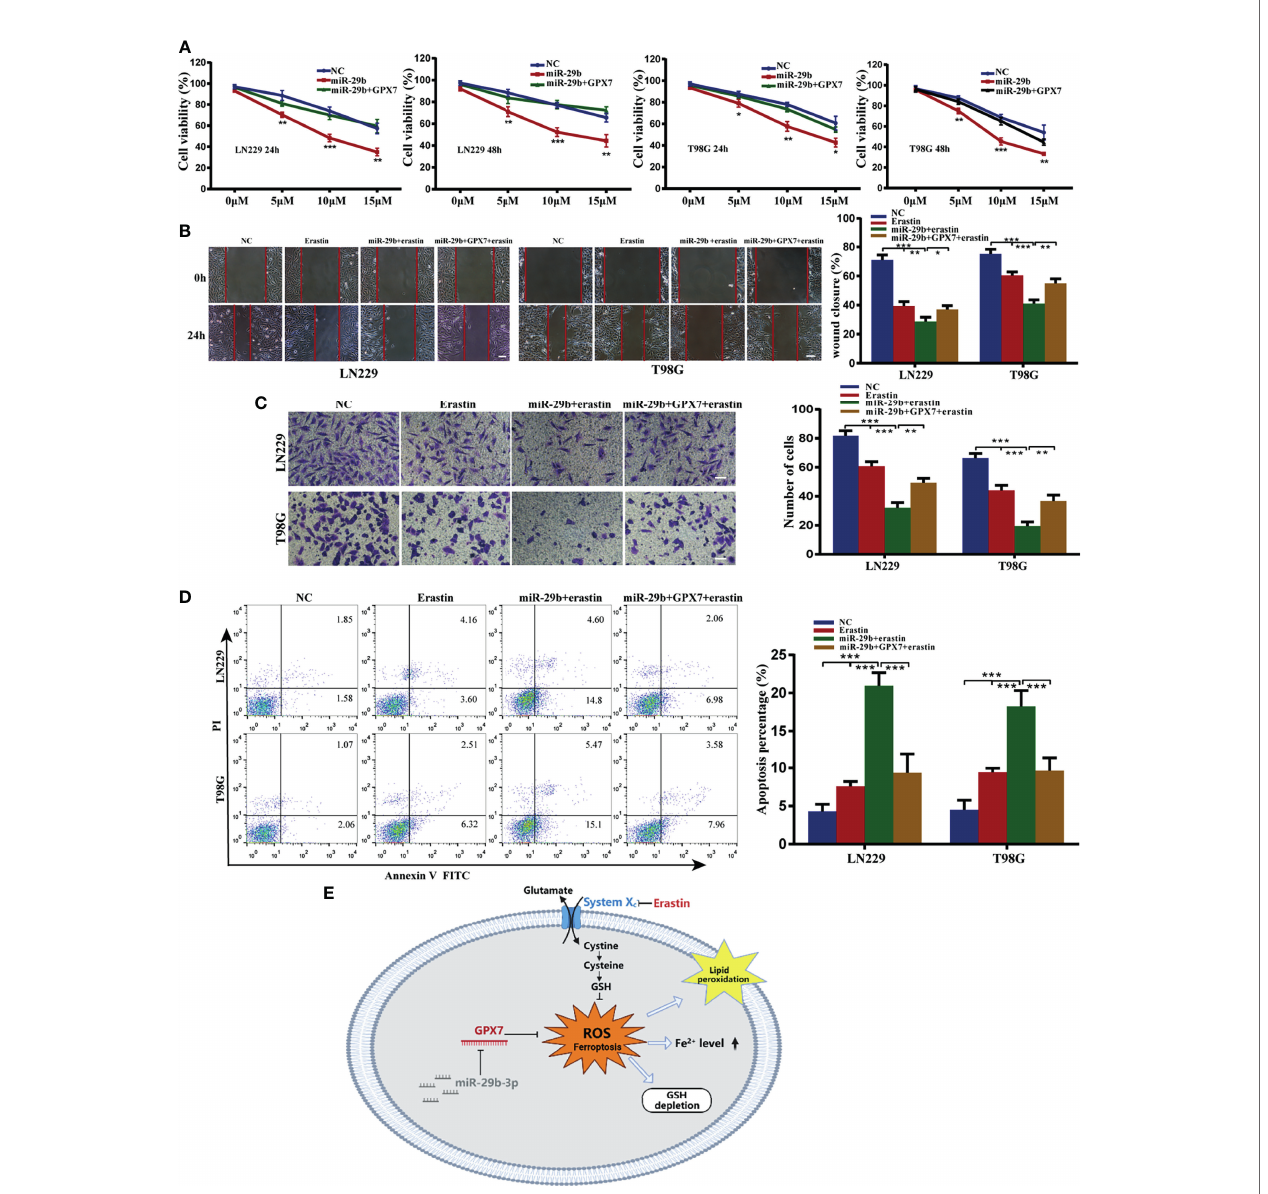
FIGURE 8 | Synergistic inhibitory effects of miR-29b mimic transfection and erastin cotreatment on glioma cells, which can be partially reversed by GPX7 restoration. (A) LN229 and T98G cells transfected with miR-29b mimic or cotransfected with miR-29b mimic and GPX7 overexpression plasmid were treated with erastin at different concentrations. Proliferation ability of cells was evaluated using CCK-8. (B) Wound healing assay. The concentration of erastin is 10 µM. Scale bar, 250 m m. (C) Transwell assay with 10 µM erastin used. Scale bar, 100 m m. (D) Annexin V and PI apoptosis assay. The concentration of erastin is 10 µM. (E) The schematic diagram of the roles of miR-29b/GPX7 in glioma ferroptosis induced by erastin, which was created on the BioRender.com. *P < 0.05, **P < 0.01, ***P <